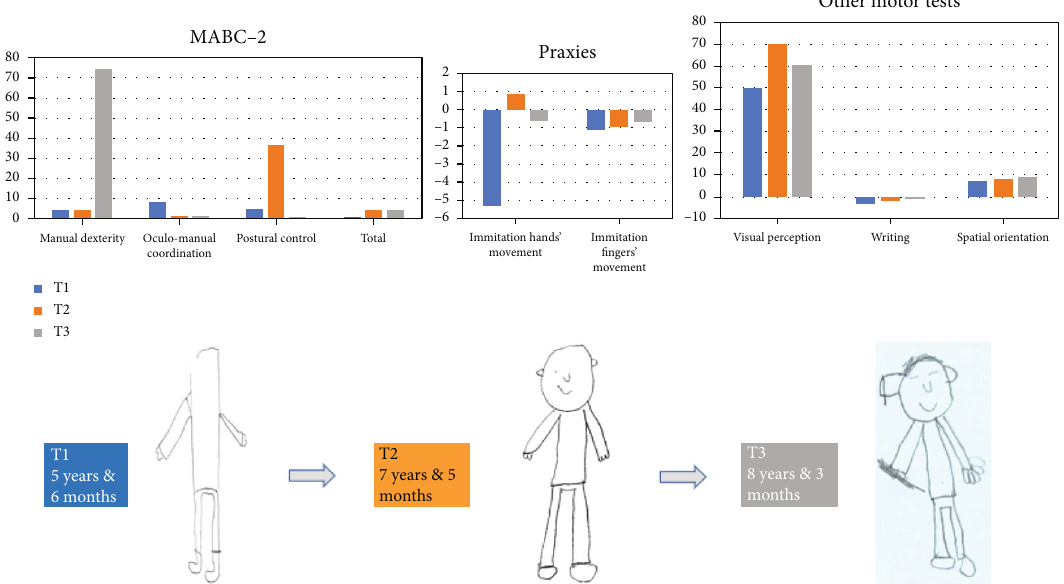
Figure 2: Evolution of motor skills in the three times of standardized assessment (MABC-2 is given in percentile. Praxies from EMG are given in standard deviation).